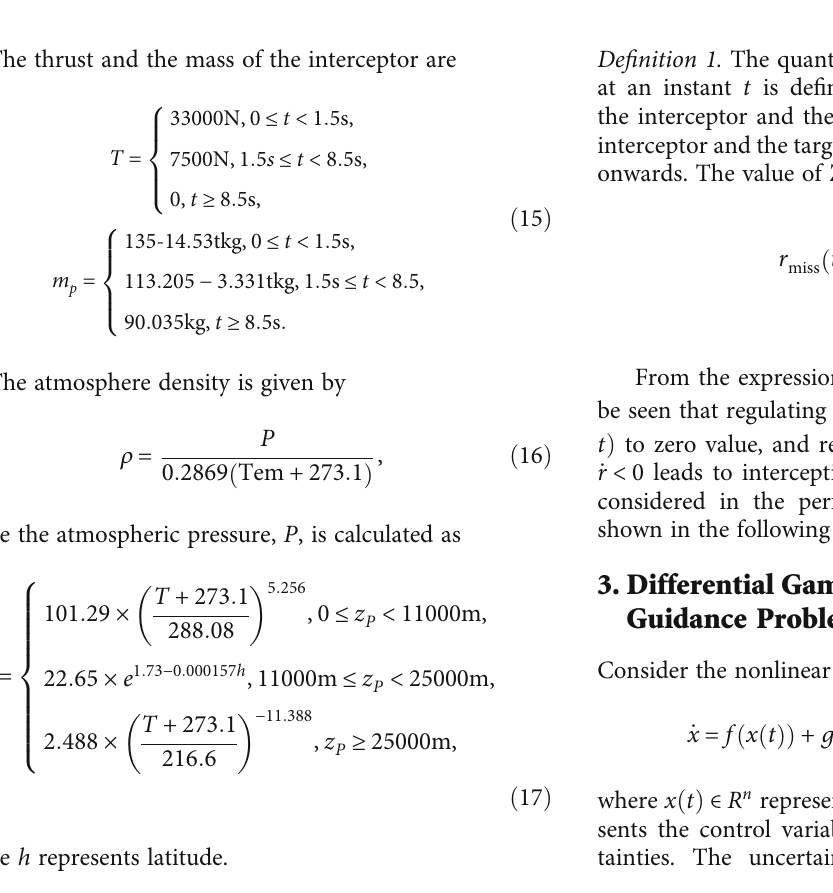
Figure 2: Flowchart of the CQPSO-PDGG